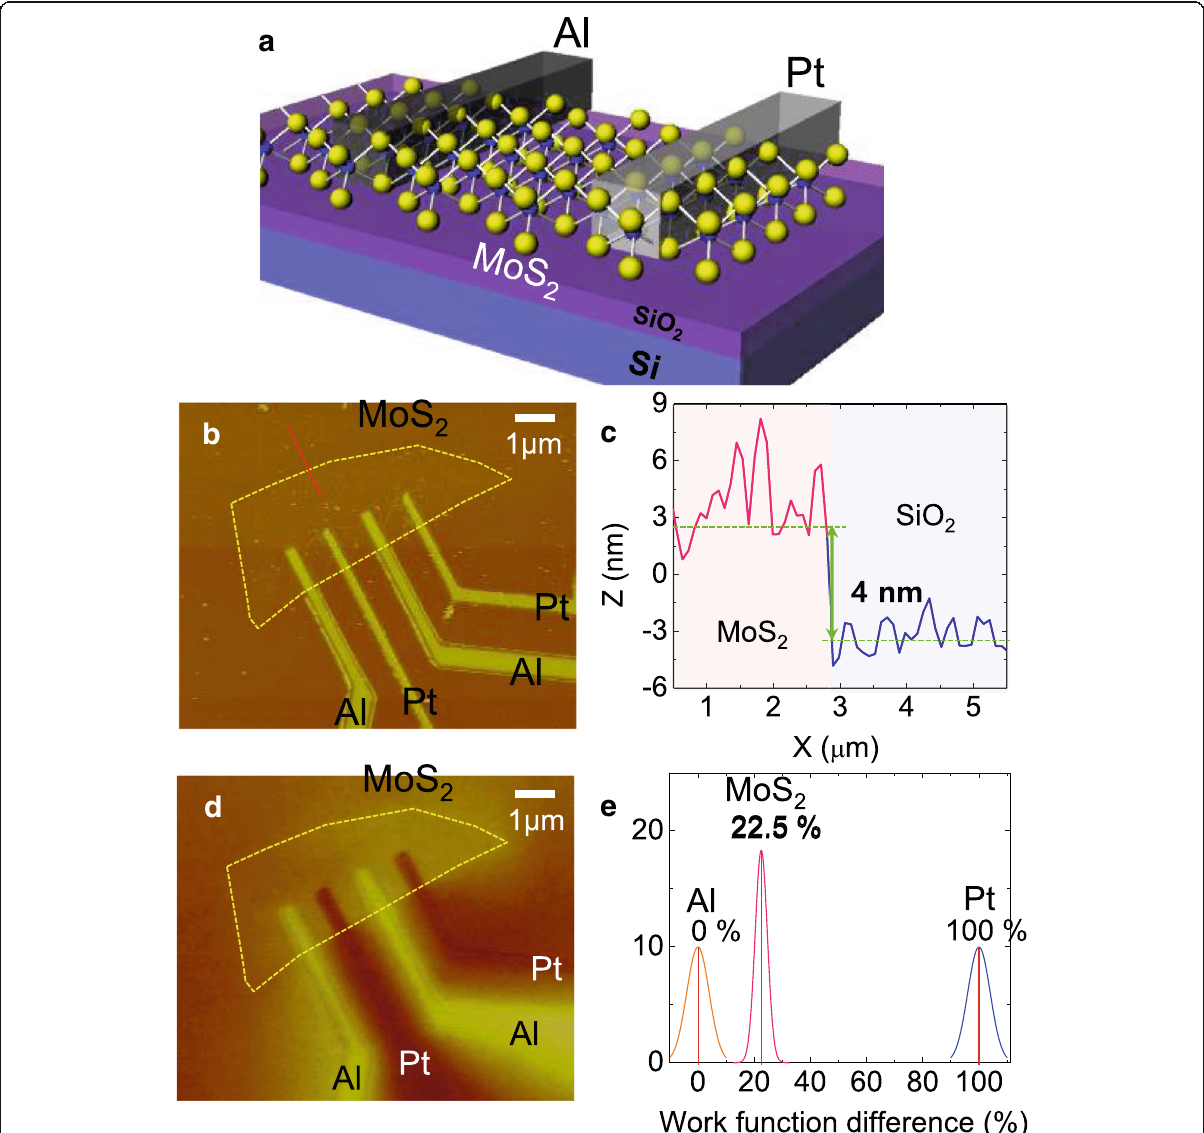
Fig. 1 a Schematic diagram of the MoS 2 Schottky diodes with Al and Pt contacts. b AFM image of the MoS 2 Schottky diode device with asymmetric metal electrodes (Al/Pt). c Cross-sectional analysis of the device for measuring the thickness of MoS 2 layer. d Surface potential image of the same device. e Normalized distribution of the relative surface potentials of MoS 2 , Al, and